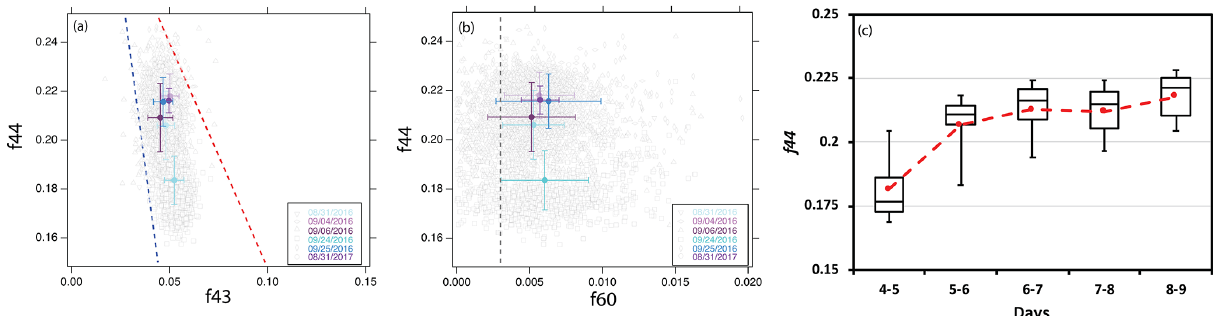
Figure 7. (a) The f 44 versus f 43 for the six flights during which OA > 20µgm − 3 . Averages ( ± standard deviation) are colored by flight date, and grey boxes indicate individual data points. Panel (b) is similar to (a) , for f 44 vs. f 60. Blue and red dashed lines define the parameters for ambient oxygenated OA, following Ng et al. (2010). (c) The f 44 versus the model-derived physical age for the six flights combined.